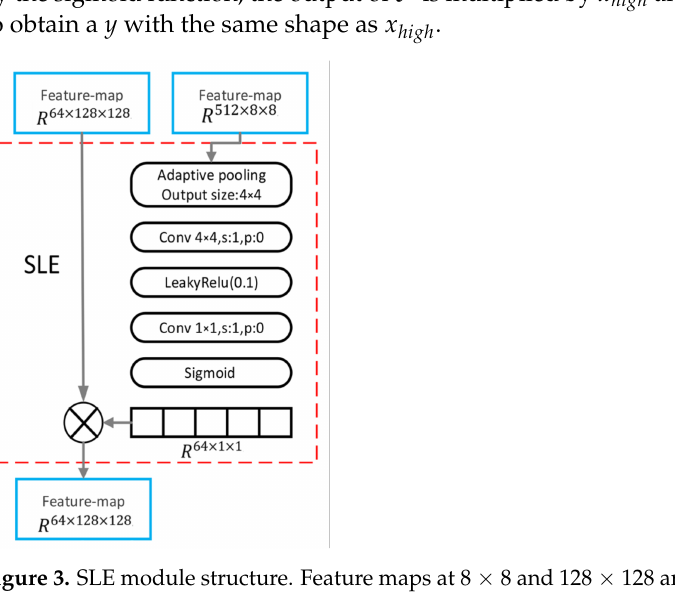
Figure 3. SLE module structure. Feature maps at 8 × 8 and 128 × 128 are, respectively, x low and x high in Equation (1). All the black boxes are used to change the size of x low